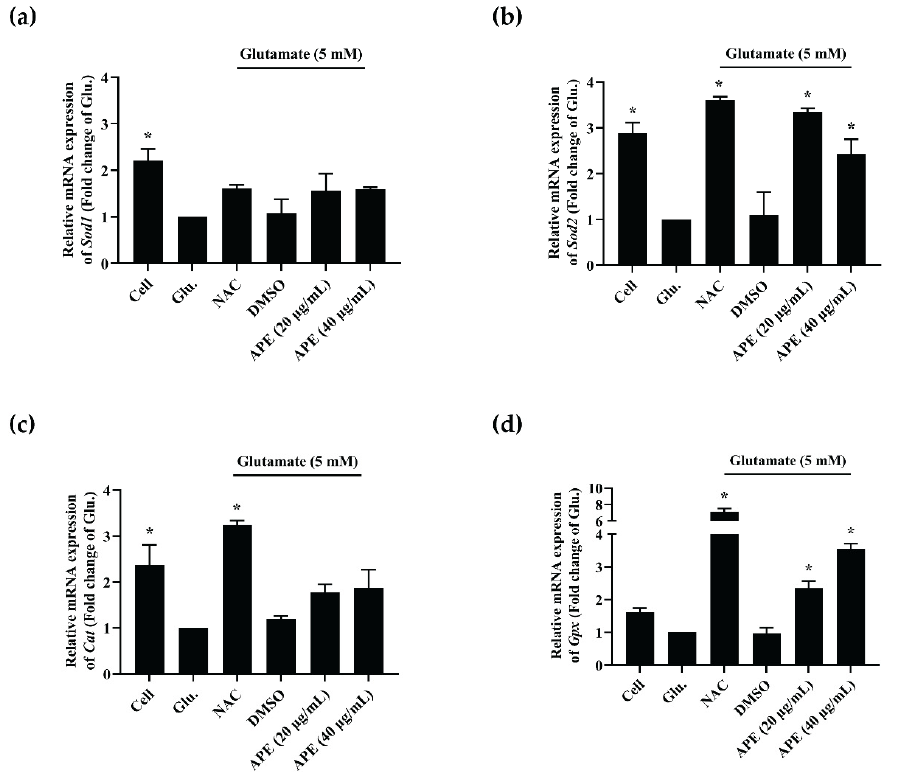
Figure 5. Antioxidant enzymes mRNA expressions: ( a ) Sod1 , ( b ) Sod2 , ( c ) Cat , and ( d ) Gpx genes of APE treatment on glutamate-induced HT-22 cell for 12 h. N -acetyl cysteine (NAC, 0.5 mM) and DMSO (0.1%, v / v ) were used as the positive and vehicle control, respectively. All data are shown as the mean ± SEM of triplicate values. Statistical significance was analyzed by one-way ANOVA, Dunnett test. * p < 0.05 versus the glutamate (Glu.) control.